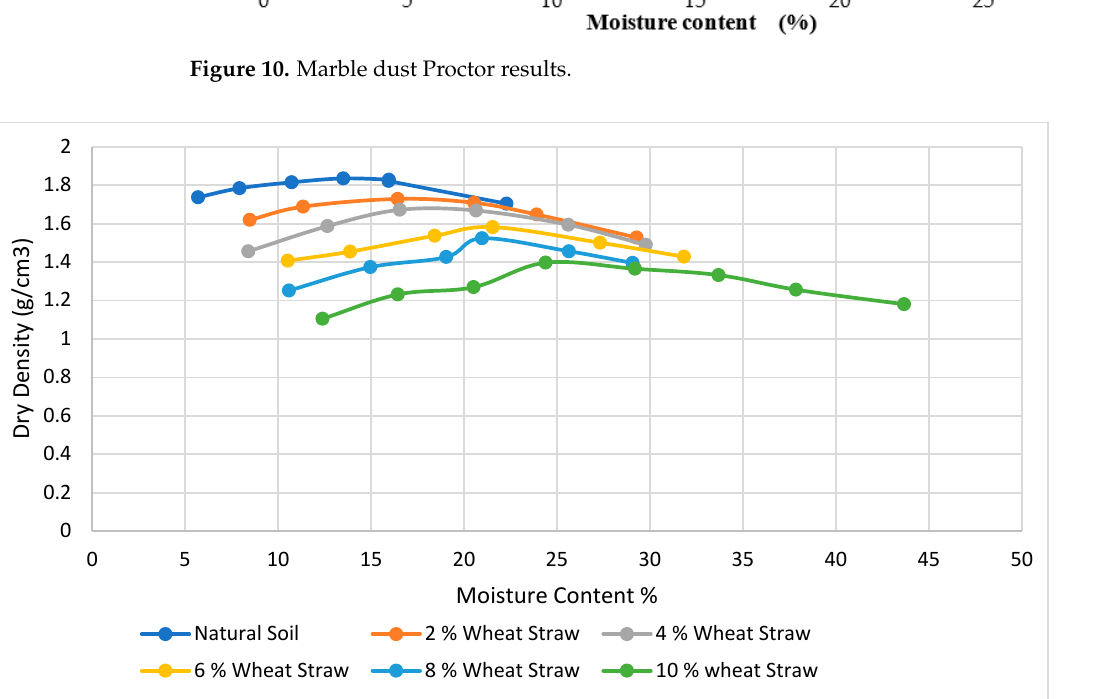
Figure 11. Wheat straw Proctor results.